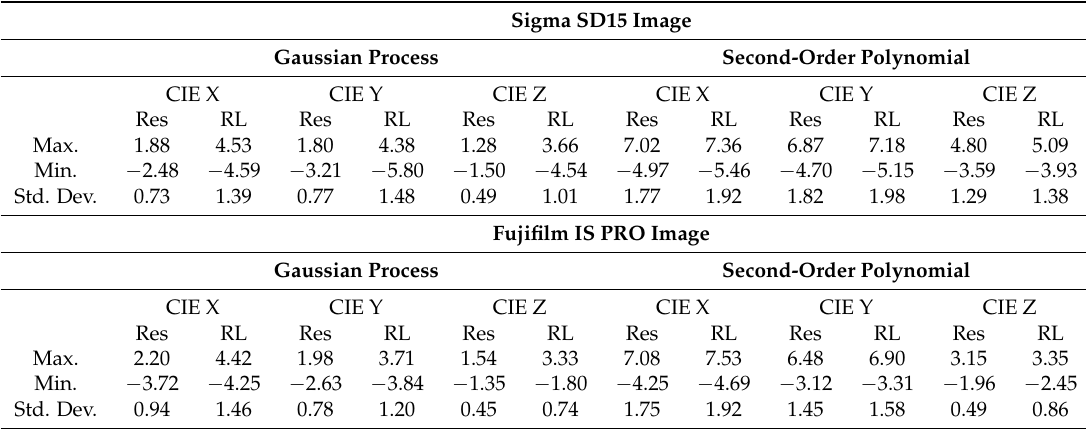
Table 1. Fitted CIE XYZ (Res) and LOOCV residuals (RL) values after the